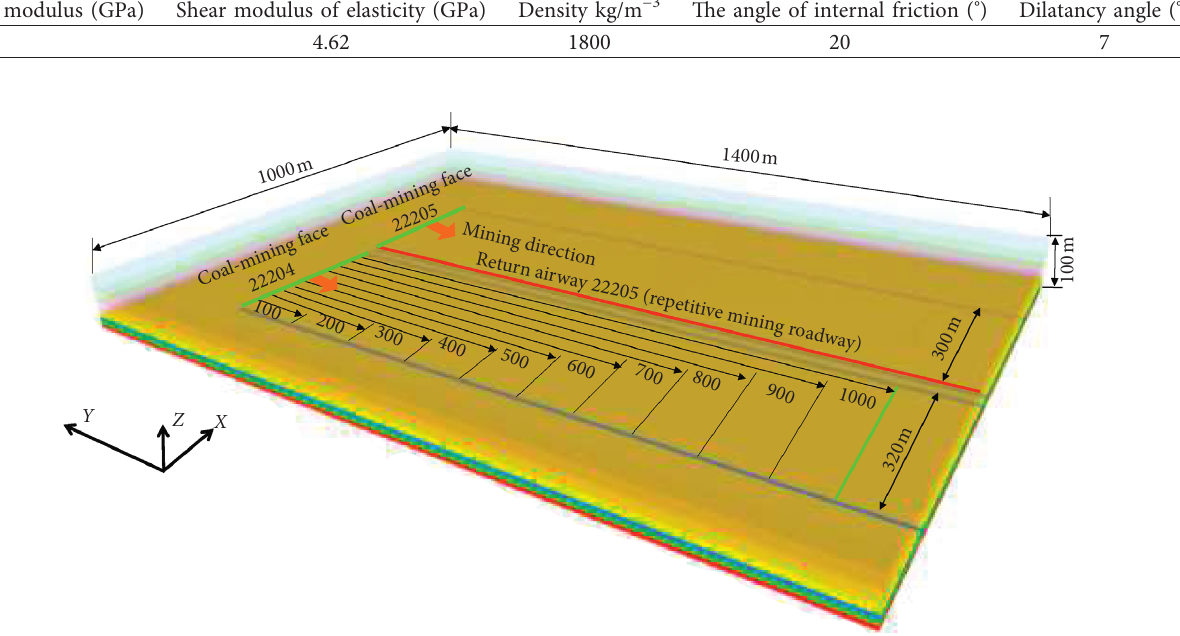
Figure 5: Numerical calculation model. Table 4: Rock mechanics parameters of the computation model.